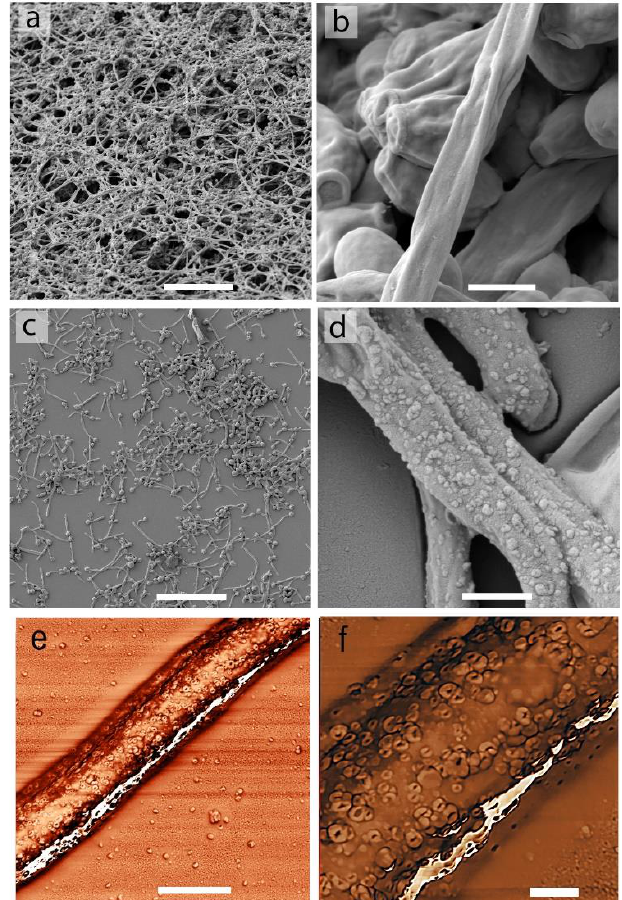
Figure 2. Microscopy investigations of C. albicans biofilm. Representative SEM images of the intact biofilm structure ( a , b ). SEM images of the biofilm formed in the presence of 2,4-DAPG (250 µg/mL) ( c , d ). Representative AFM images (phase shift mode) of hyphae treated with 2,4-DAPG (250 µg/mL) ( e ) and enlarged area of hyphae surface with protrusions ( f ). Scale bars — 50 µm ( a , c ); 2 µm ( b , d , e ); 200 nm ( f ).